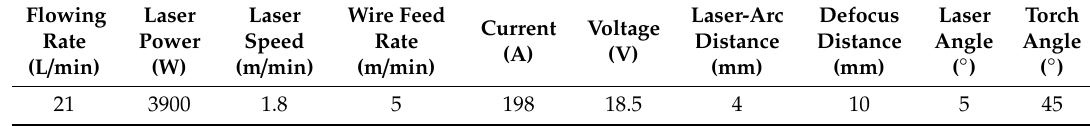
Figure 1. ( a ) Laser-arc hybrid welding apparatus and ( b ) schematic of the process. Table 2. Processing parameters used in the laser-arc hybrid welding.